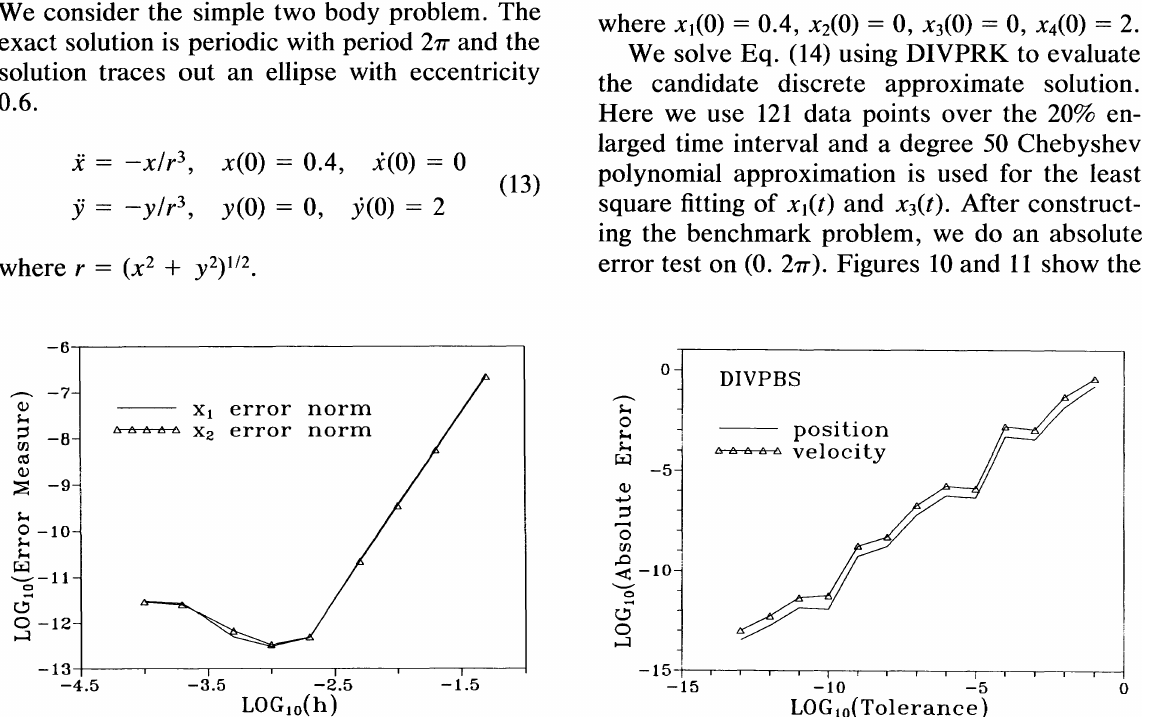
FIGURE 11 Absolute error vs. tolerance for the benchmark problem